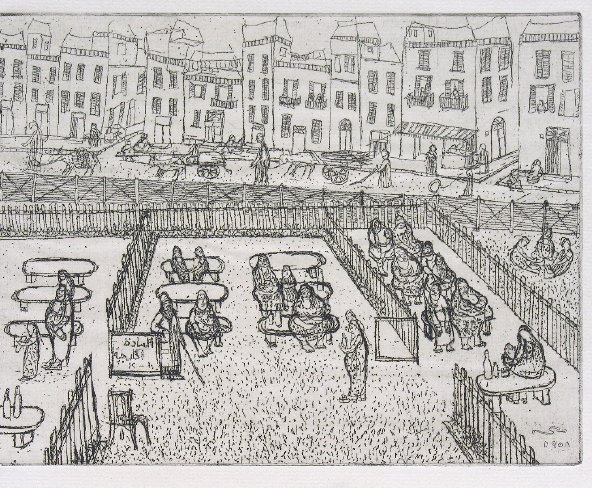
Figure 6. Menhat Helmy, Outpatient Clinic (1958). Etching. Courtesy of estate of Menhat Helmy.